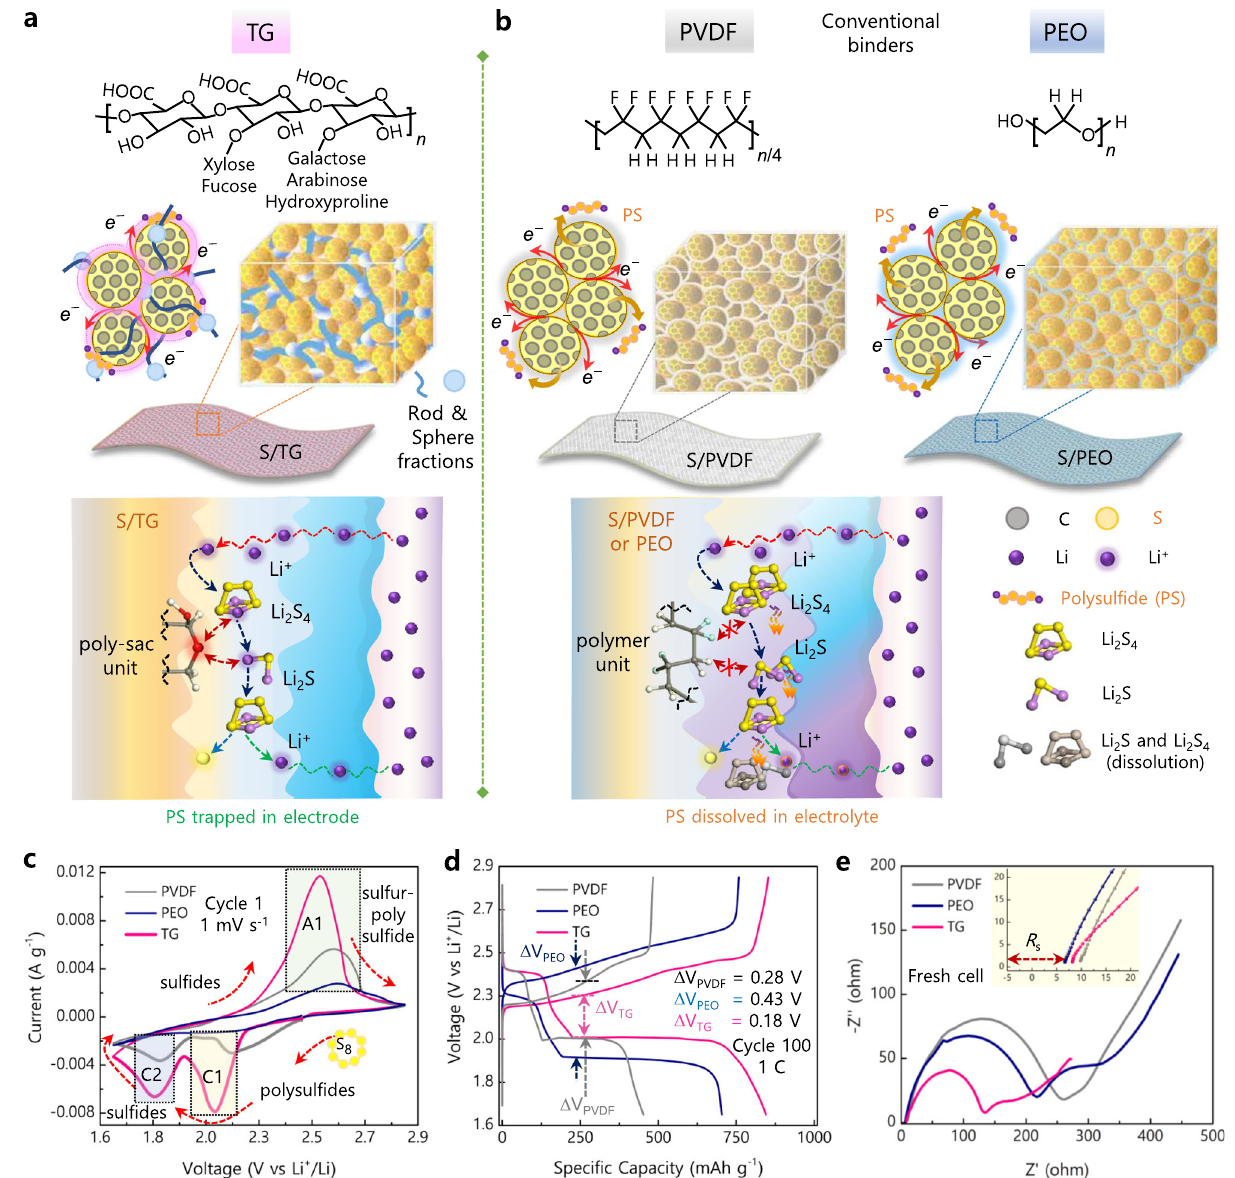
Fig. 1 Schematic illustration of the fabrication, architecture, and properties of various binders for sulfur cathodes. a , b The cathode is comprised of sulfur loaded into ‘ Super P ’ carbon with binders. a Tragacanth gum (TG). b Polyvinylidene di fl uoride (PVDF) and poly(ethylene oxide) (PEO). c – e Electrochemical performance of sulfur cathodes fabricated using TG as the binder, S/TG electrodes against the PVDF, S/PVDF, and PEO, S/PEO for Li- S battery. c Cyclic voltammograms recorded between 1.7 and 2.8 V (Li + /Li) at a scan rate of 1 mV s – 1 . d Galvanostatic discharge-charge pro fi les measured at a current rate of 1 C (1 C = 1675 mA g – 1 ). e Nyquist plots for the fresh Li-S cells employing various